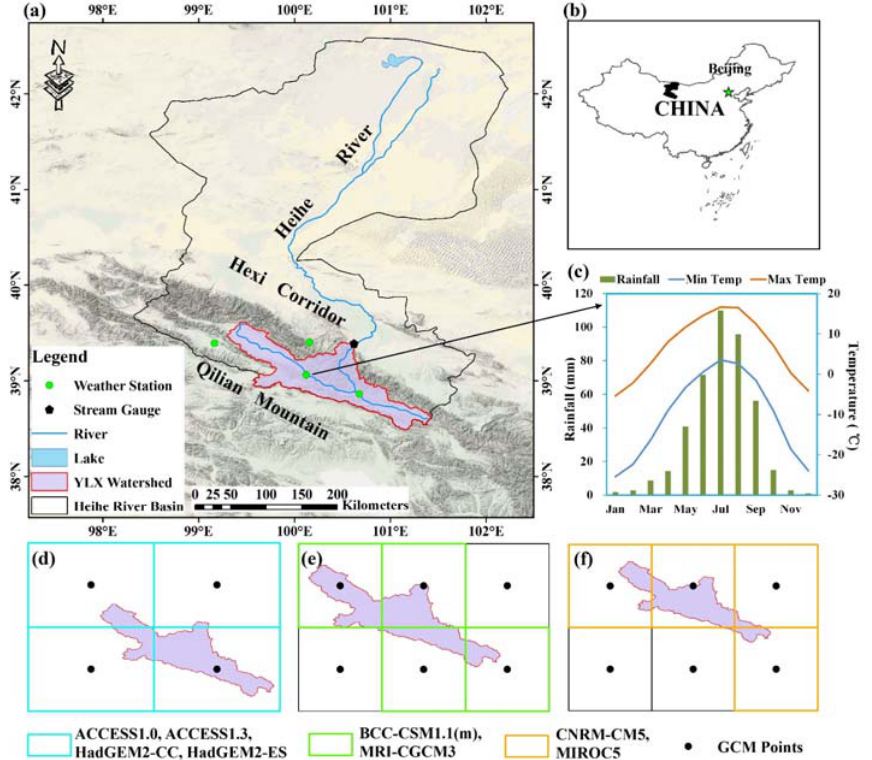
Figure 1. ( a ) and ( b ) Location of the Yingluoxia (YLX) Watershed; ( c ) mean monthly rainfall and temperature at the Yeniugou weather station from 1961 to 2013; ( d ) the global climate model (GCM) points and grids of ACCESS1.0, ACCESS1.3, HadGEM2-CC and HadGEM2-ES; ( e ) the GCM points and grids of BCC-CSM1.1(m) and MRI-CGCM3; ( f ) the GCM points and grids of CNRM-CM5 and MIROC5.